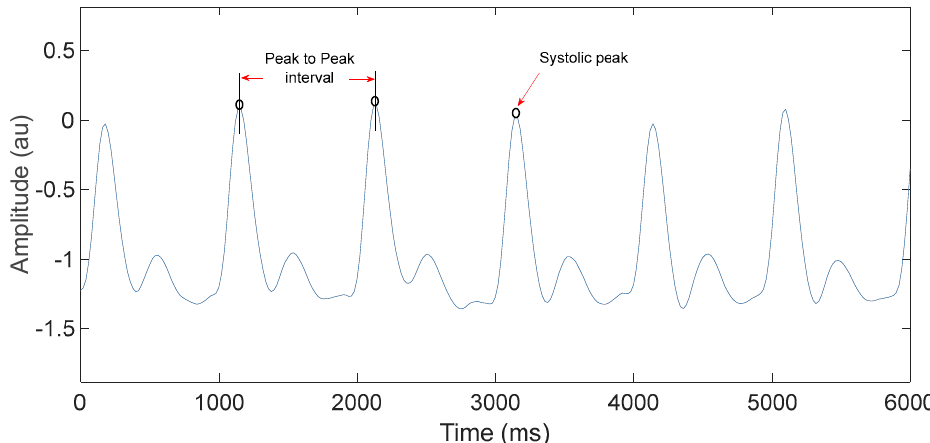
Figure 6. Systolic peaks and peak-to-peak intervals of a PPG signal measured by the NeXus-10 MKII device signal in the dry environment.